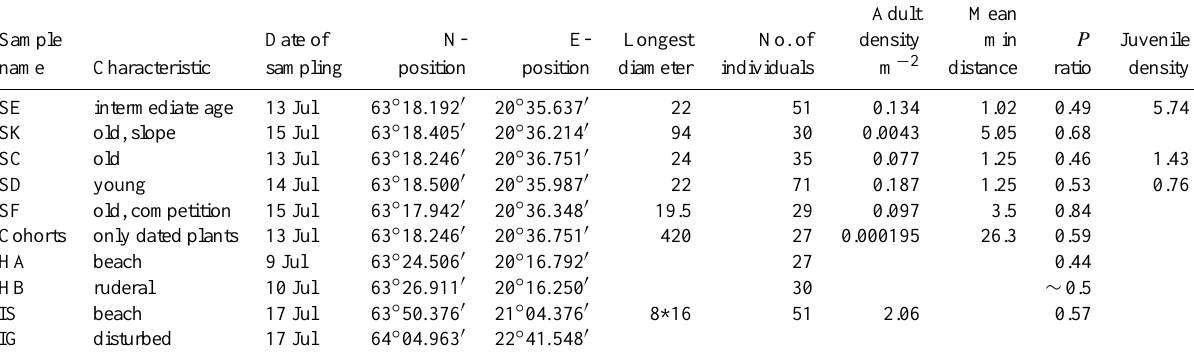
Table 1. Honckenya peploides sample properties. S – samples from Surtsey, H – samples from Heimaey, I – samples from mainland Iceland. Names are the same as in Árnarson et al. (2014). Individuals are flowering individuals. Longest diameter (m) is double the distance from the farthest individual to the sample centre. Min. distance (m) is the distance from an individual to its nearest flowering neighbour. P ratio is the proportion of pistillate individuals in the sample. For the populations HA, HB and IG the sample areas were of irregular shape or fragmented, so it was not possible to obtain reliable measures of density or distance between individuals.